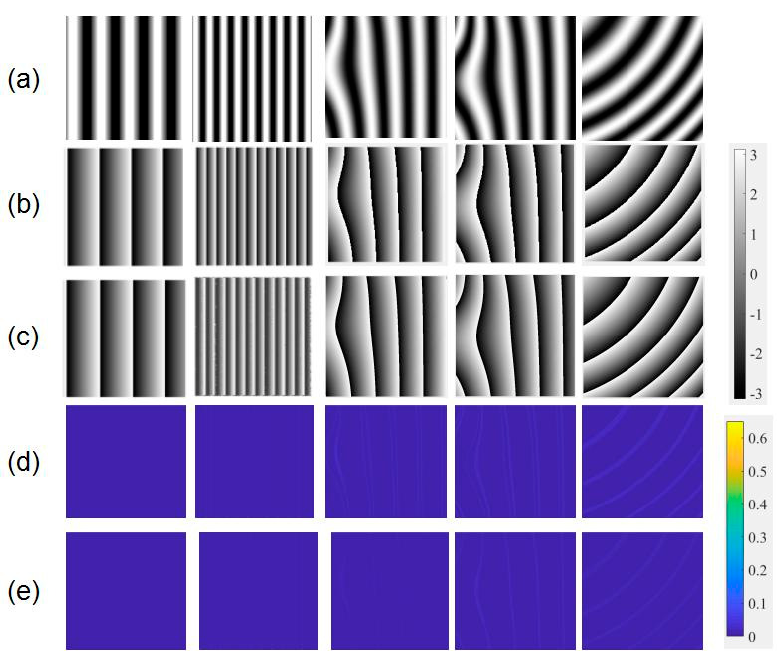
Figure 11. ( a ) Simulated fringe patterns, wrapped phase maps calculated from ( b ) four-step phase shifting method, and ( c ) neural network, and corresponding error maps from ( d ) wavelet transform method, and ( e ) neural network.